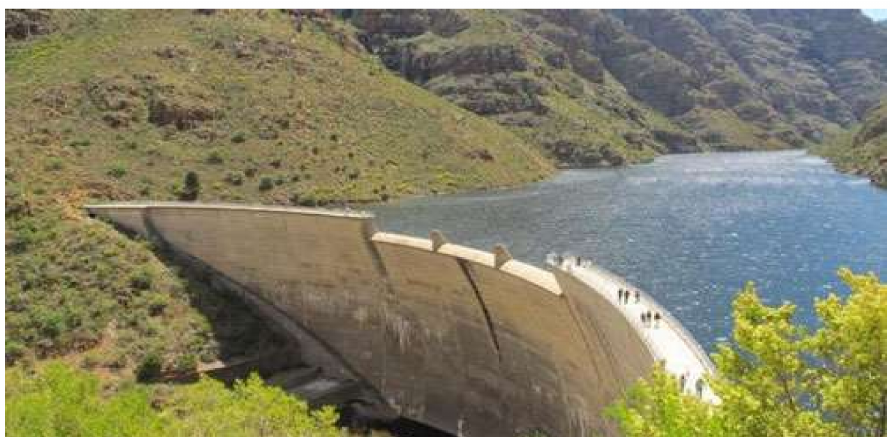
Figure 3. Roode Elsberg dam.